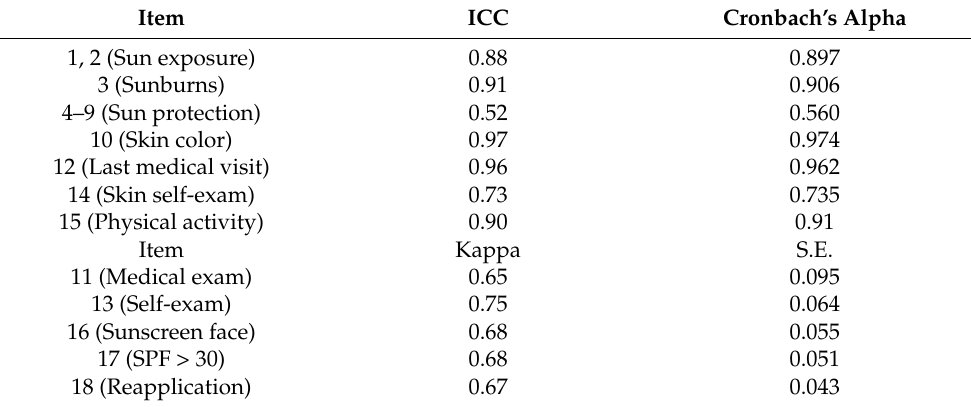
Table 5. Reliability with respect to stability (intraclass correlation coefficient (ICC) and Kappa) and internal consistency (Cronbach’s